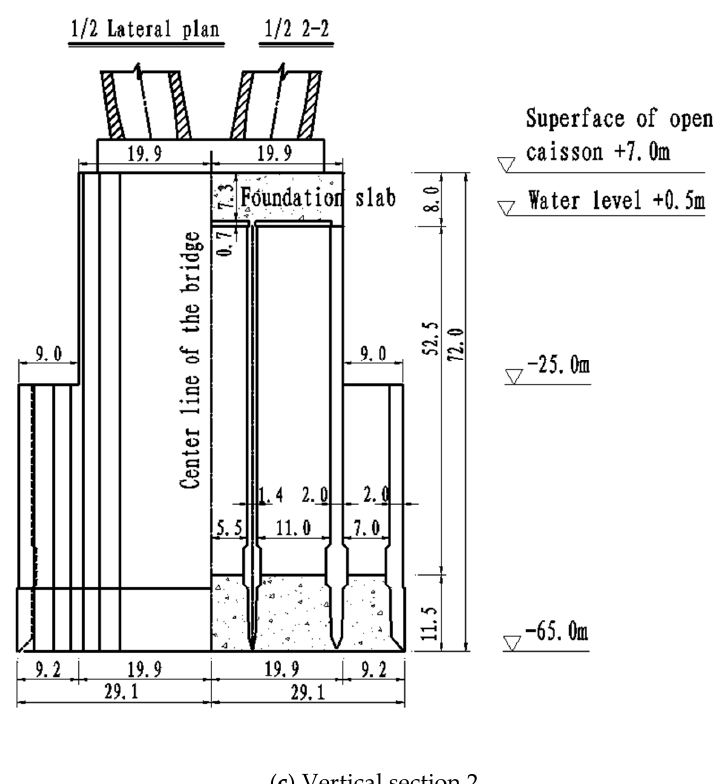
Figure 2. Structure of caisson foundation (unit:m).